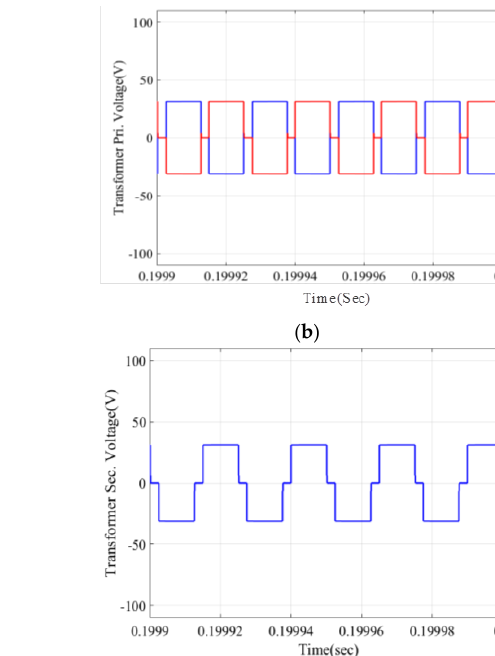
Figure 15. Simulation and experimental results for inductor currents: ( a ) experimental results for I L1 (Amp/div = 1 A, Time/div = 10 µs), ( b ) simulation results for I L1 , ( c ) experimental results for I L2 (Amp/div= 1 A, Time/div = 10 µs) and ( d ) simulation results for I L2 .